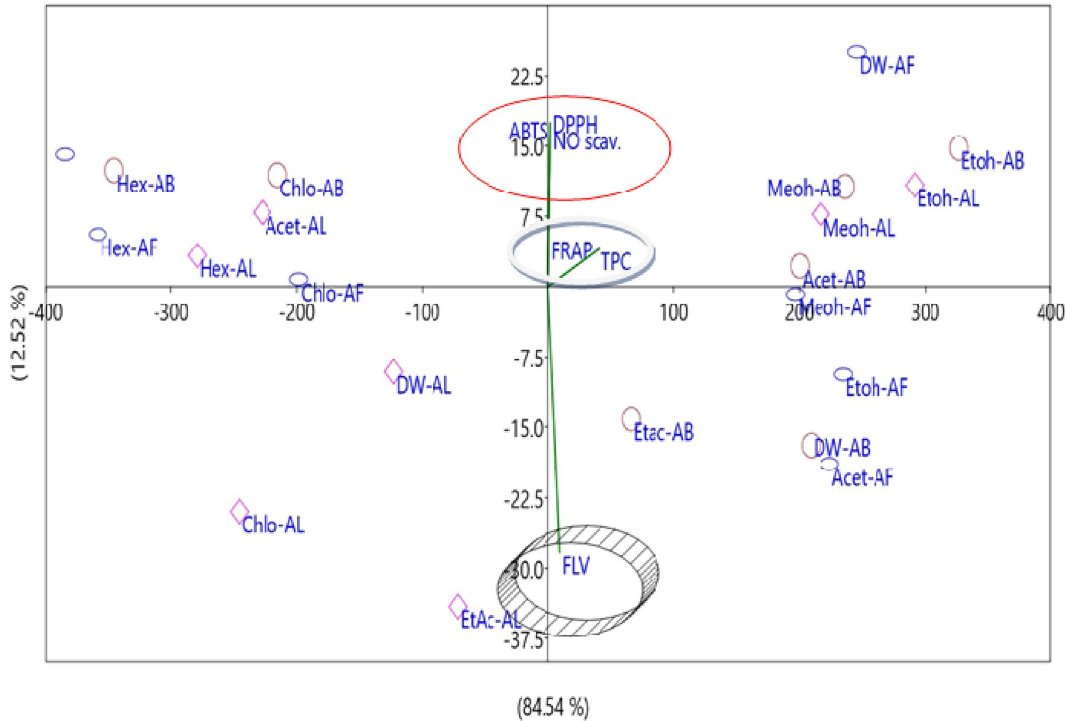
Figure 5. PCA scatter bi-plot of Antioxidants and solvent extracts of T. arjuna . Components 1 and 2 describe differences depending on the Eigen values of the various components. Component 1 describes the overall variance, which shows the best fit of the experimental results. FRAP is closely related to Etoh-AB and Meoh-AB, while TPC is related to Etoh-AF and Meoh-AF. TPC is closely linked to FLV material, while FRAP is strongly associated with DPPH, ABTS, and